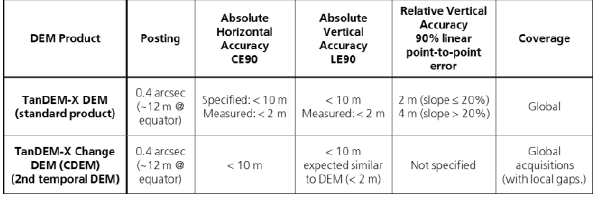
Table 2. TanDEM-X DEM and Change DEM specifications